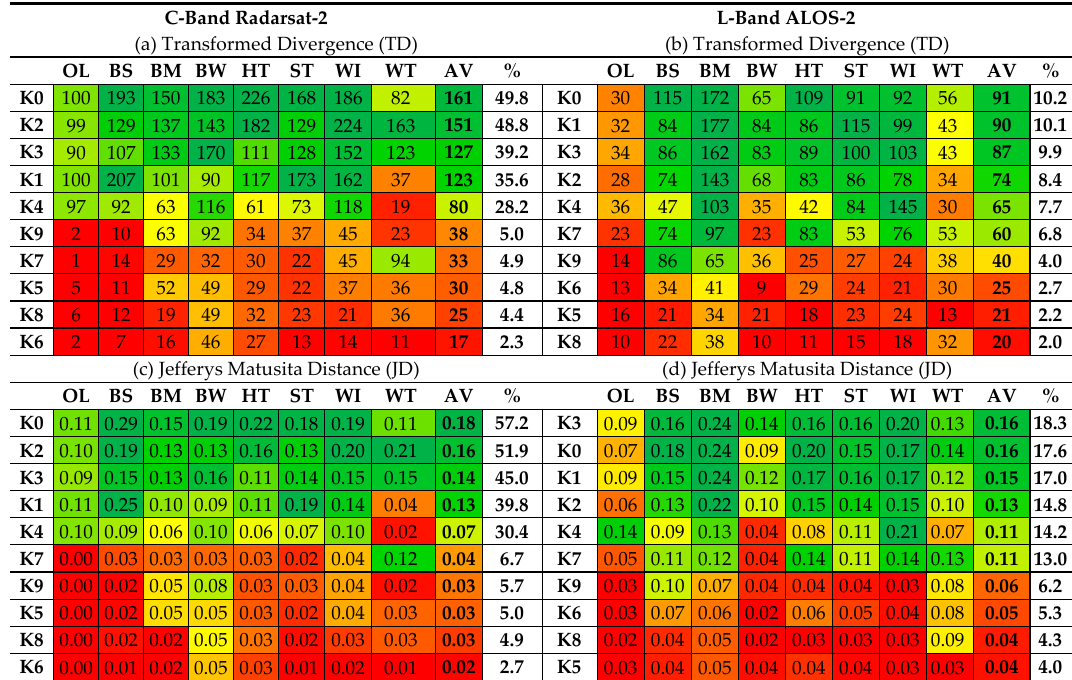
Table 6. Average increase of the separability features: ( a – b ) Transformed Divergence (TD) and ( c – d ) squared Jefferys Matusita Distance (JD) for Kennaugh-Matrix elements K0-K9 of quad-polarimetric C-Band Radarsat-2 (left column) and L-Band ALOS-2 (right column) data and for classes OL (Permanent Water Bodies), BS (Sand), BM (Mixed Sediment), BW (Driftwood Accumulation), HT (Herb Dominated Tundra), ST (Shrub Dominated Tundra), WI (Inundated Low Lying Tundra) and WT (Wetland) (see Table 2). The features are ranked in descending order of the average increase in separability (AV). The last column displays the AV in percent (%) The colors from red to yellow to green correspond to the 10%, 50% and 90% quantiles of the AV data range. The metric displays the average increase in separability when a feature of interest (K0–K9) is added to an existing feature space (see Section 2.3 Correlation, Class Separability and Feature Selection ).